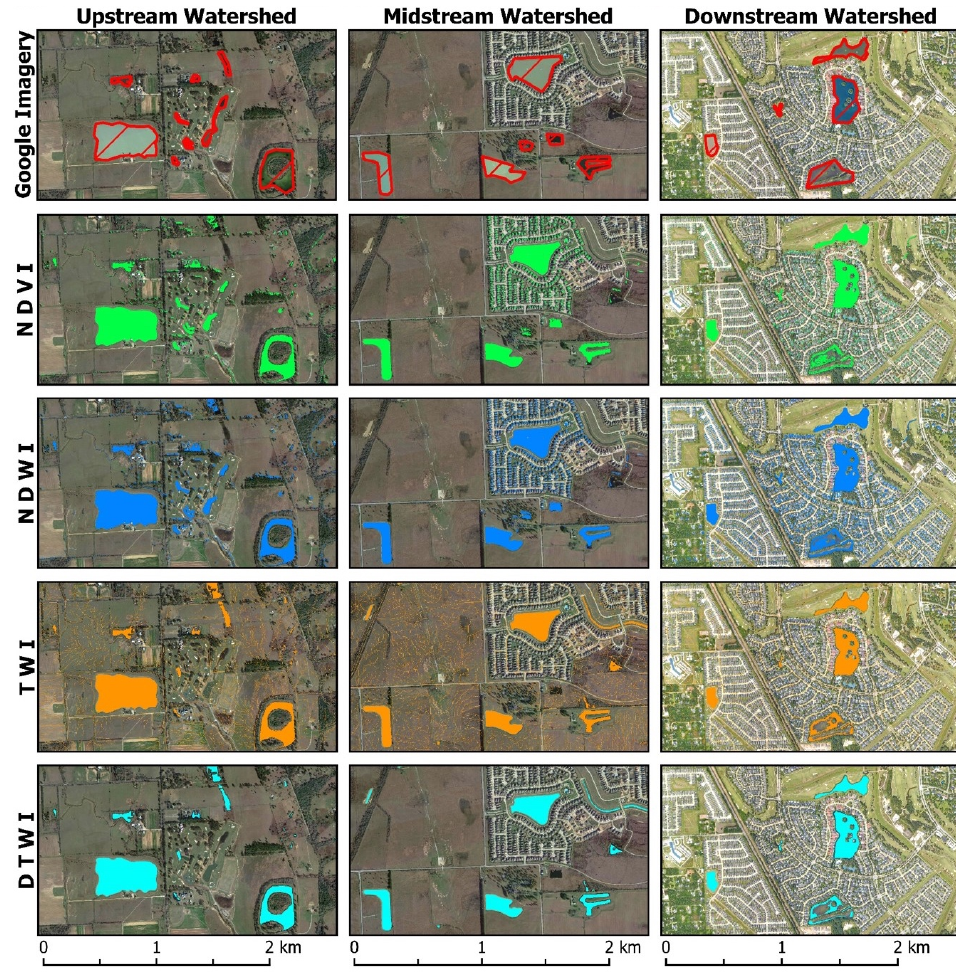
Figure 5. The wetland delineation of four indices in upstream (natural/agricultural), midstream (mixed agriculture-residential), and downstream (residential) sub-watersheds.